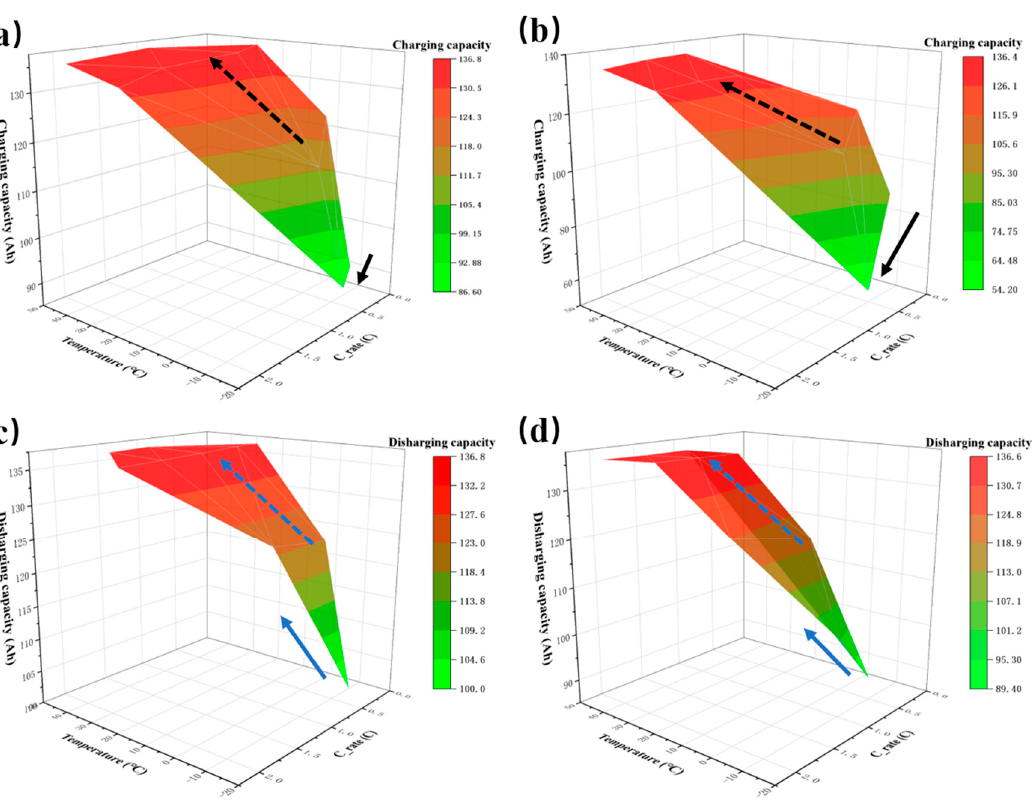
Figure 5. Capacity Charge/discharge Rate Temperature 3D plot of large-size battery for two tests. ( a , b ) Charging capacity (first/second test); ( c , d ) Discharging capacity (first/second test).